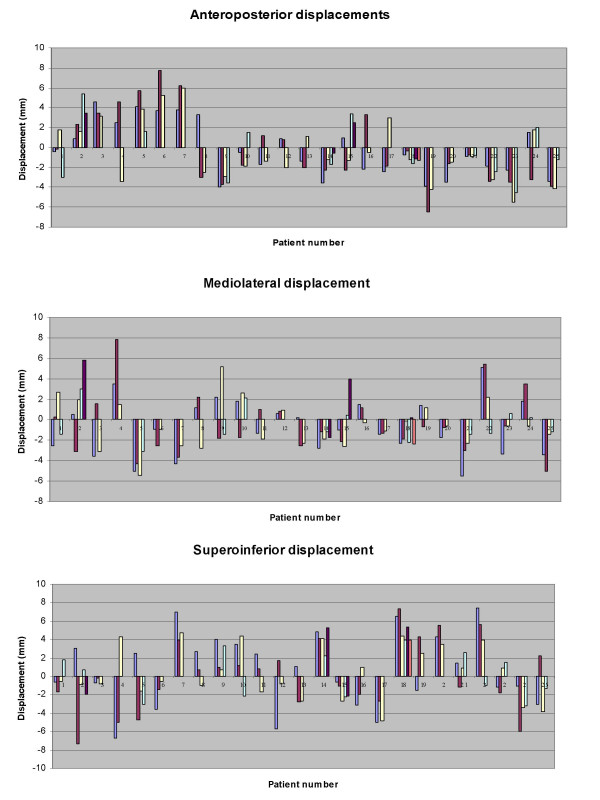
Patient-wise distribution of set-up deviation in all three directions.